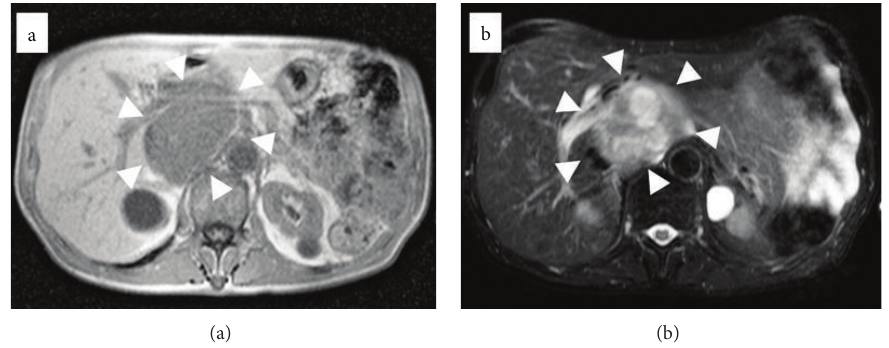
Figure 2: Magnetic resonance imaging (MRI) of the abdomen. Magnetic resonance imaging (MRI) of this tumor revealed a contrasting low intensity on the T1-weighted image ((a) arrow head) and high intensity on the T2-weighted image ((b) arrow head).